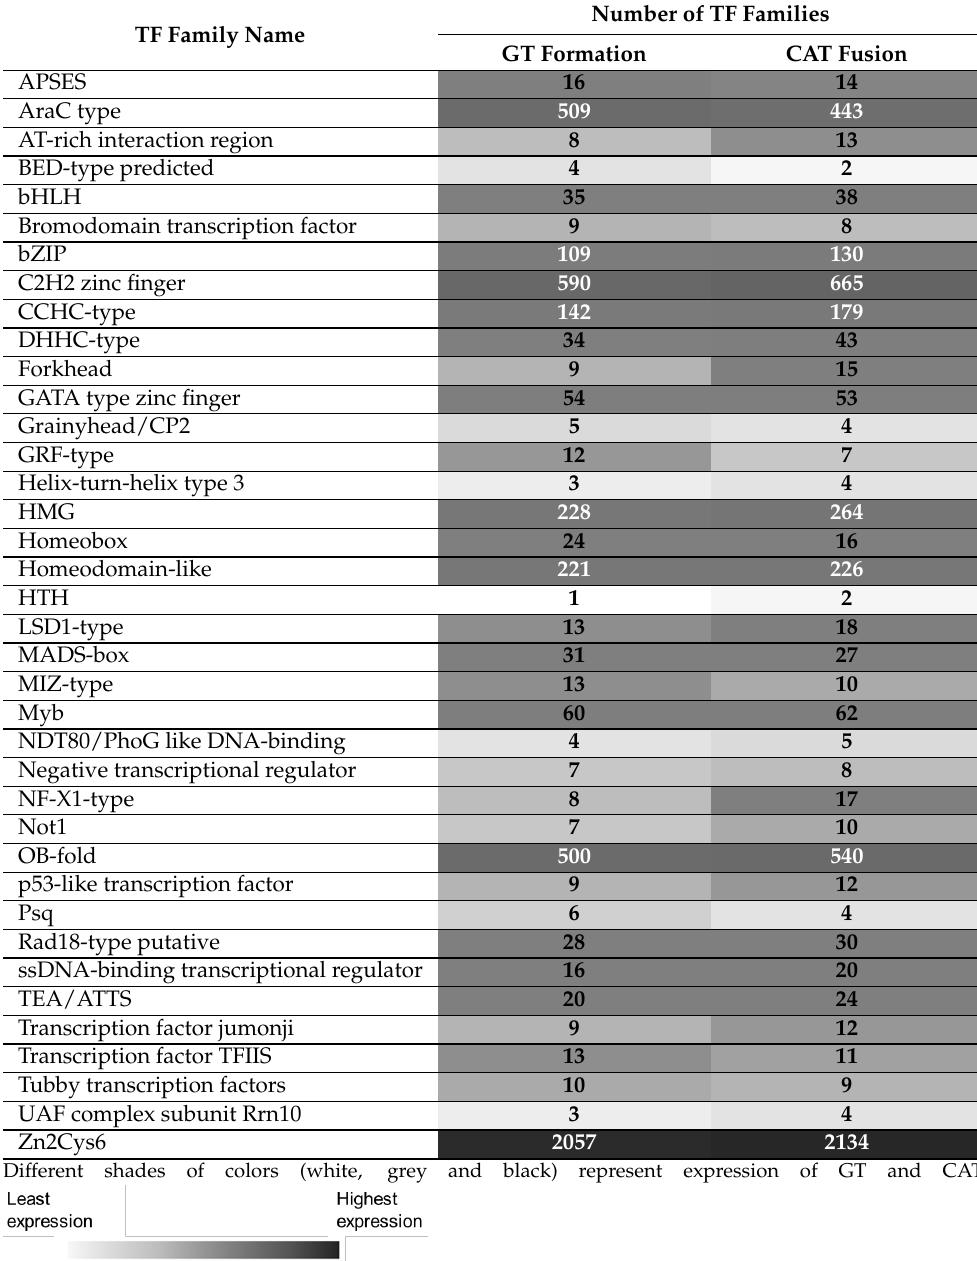
Table 3. Transcription factors families and their expression values involved in GT formation and CAT fusion in C. gloeosporioides